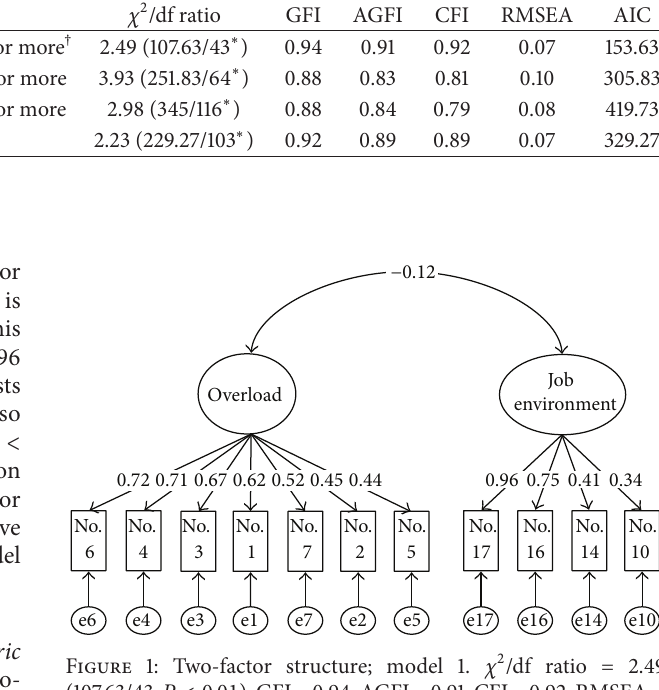
Table 5: The goodness of fit in models.